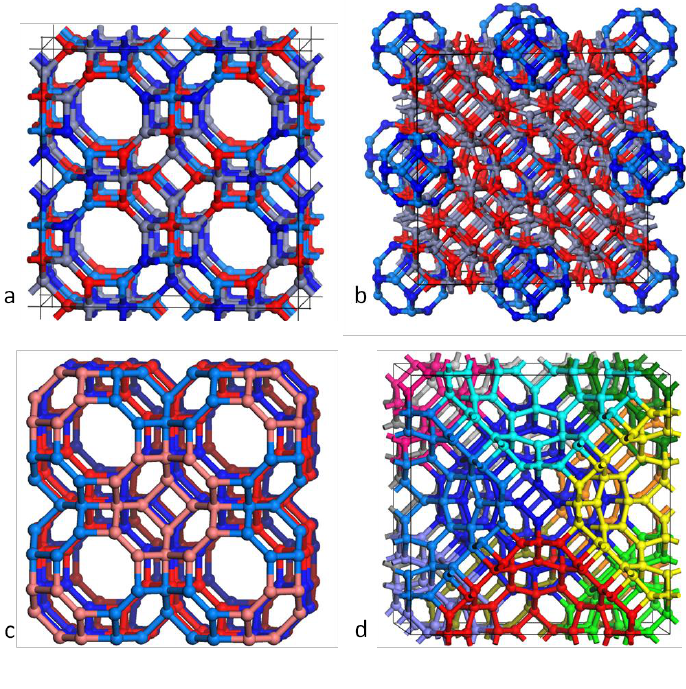
Figure 4. Ball and stick models of two framework structures. ( a ) Constructed from T bubbles of (GaN) and (ZnO) ; ( b ) Constructed from T double bubbles of (ZnO) 12 12 h (GaN) ; ( c ) the same structure as (a) but with each (GaN) coloured red and each (ZnO) 12 12 coloured blue (lighter/darker shades used in the front/back row); ( d ) the same structure as (b) but with each (GaN) hidden and each (ZnO) uniquely 12 48